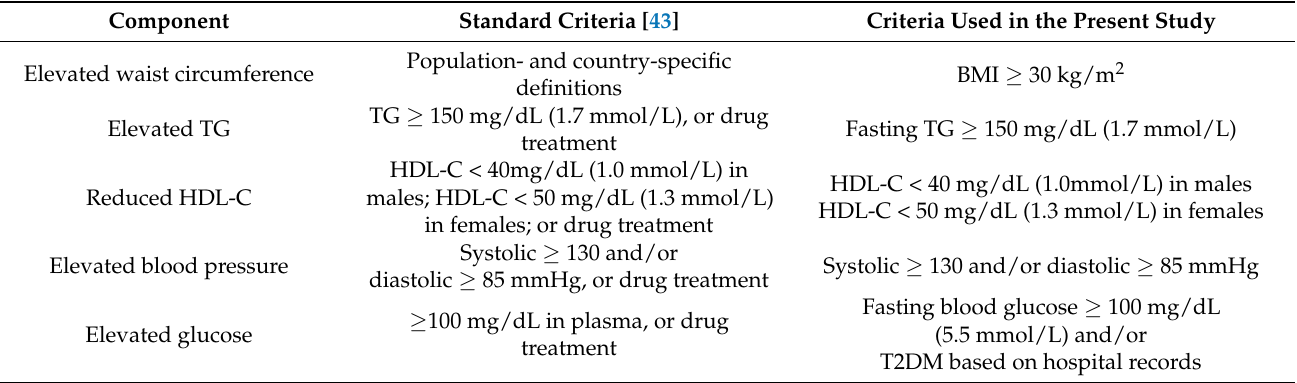
Table 5. Definition of metabolic syndrome.